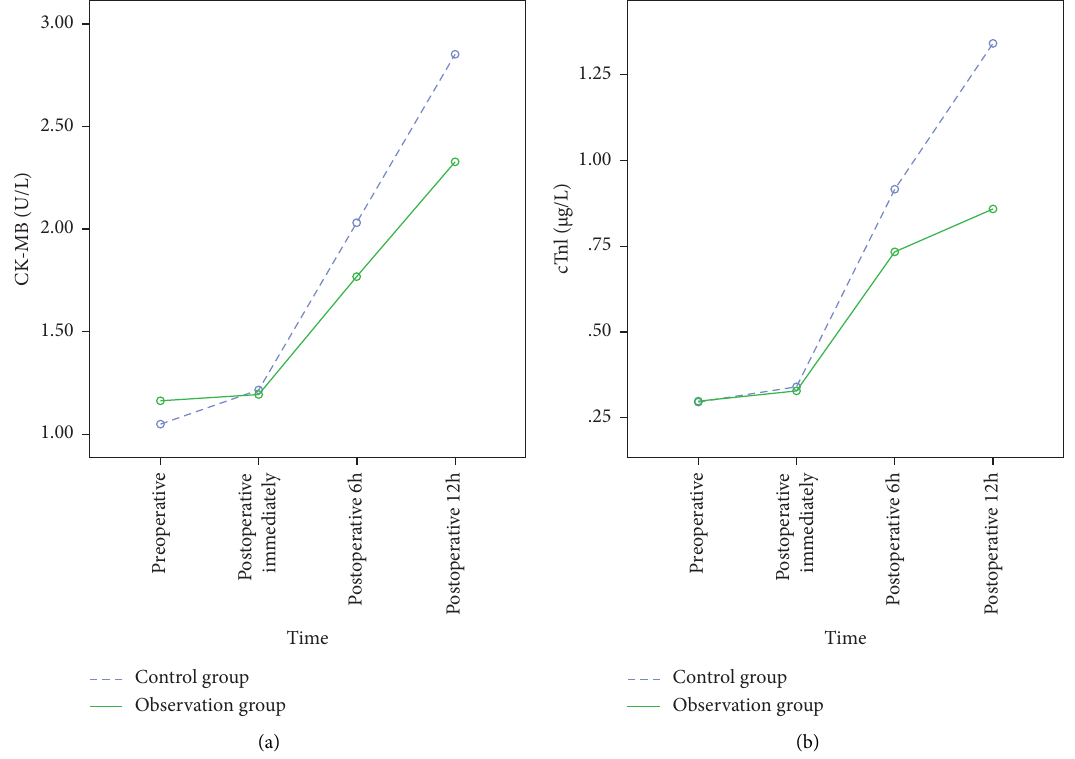
Figure 4: Comparison of perioperative serum myocardial injury indexes between the two groups (Note. (a) Comparison of perioperative CK-MB levels between observation group and control group; (b) comparison of perioperative cTnI levels between the observation group and control group). Table 4: Comparison of perioperative serum myocardial injury indexes between the two groups ( x ± s ).